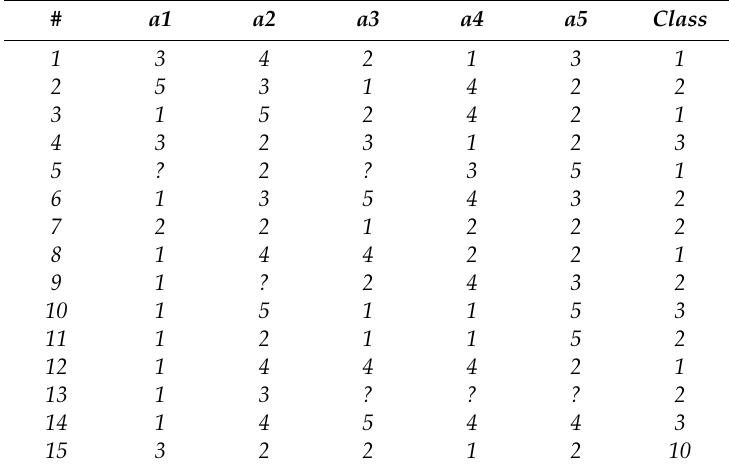
Table 1. Training dataset.